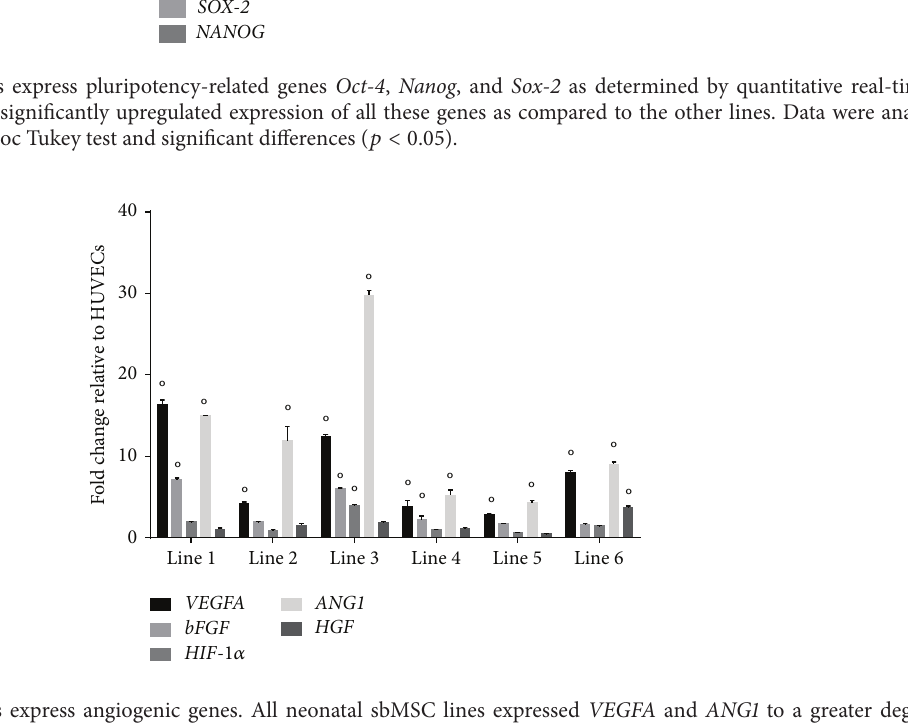
Figure 5: Neonatal sbMSCs express angiogenic genes. All neonatal sbMSC lines expressed VEGFA and ANG1 to a greater degree than HUVECs, whereas half of the sbMSCs lines evaluated also had increased bFGF expression. Data were analyzed by two-way ANOVA with post hoc Tukey test ( ∘ designates 𝑝 < 0.05 versus